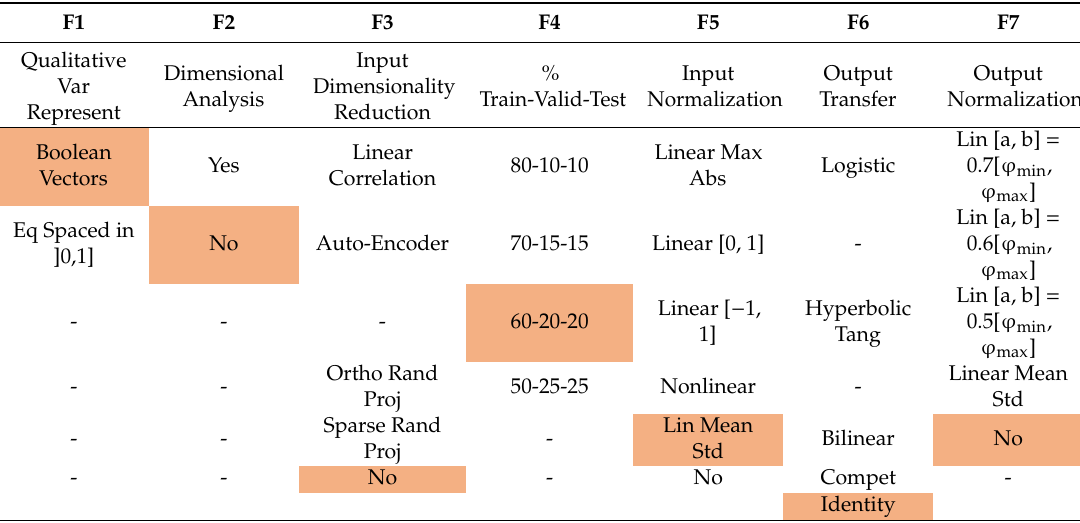
Table 3. Implemented artificial neural network (ANN) features (F) 1–7. The highlighted cells show the features that were used to derive the final neural net.